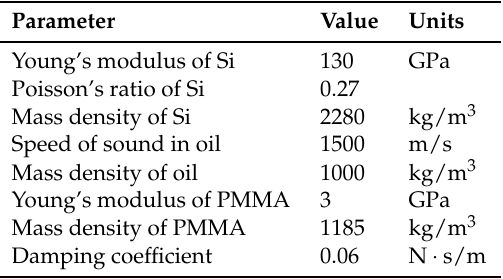
Table A1. Simulation parameters.